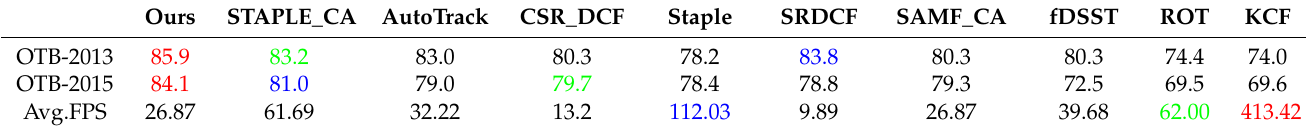
Table 2. Precision rates (% at CLE = 20 pixs) of our proposed Ad_SASTCA versus other state-of-the-art trackers on OTB-2013 and OTB-2015. The best method is indicated in red, and the second and third are indicated in blue and green,